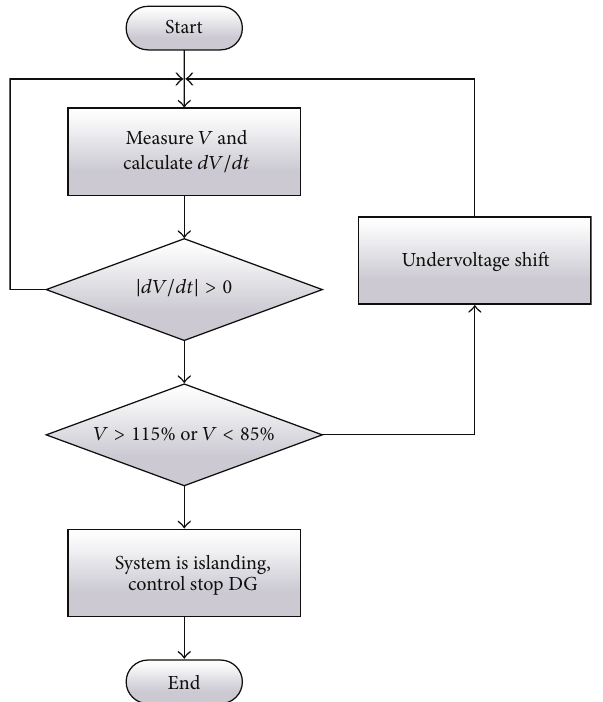
Figure 12: Over/undervoltage and undervoltage shift algorithm.